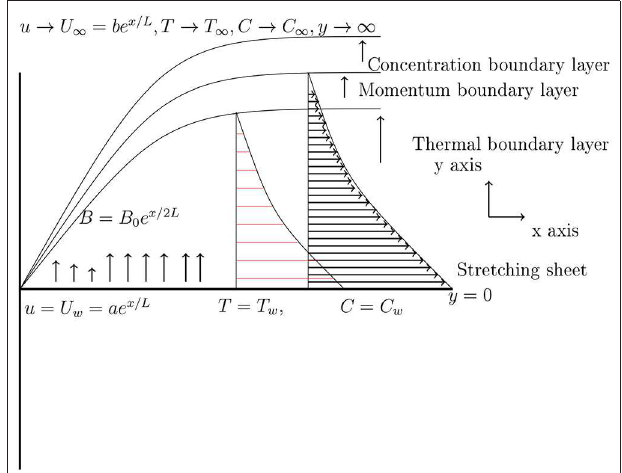
FIGURE 1 | Structure of the flow